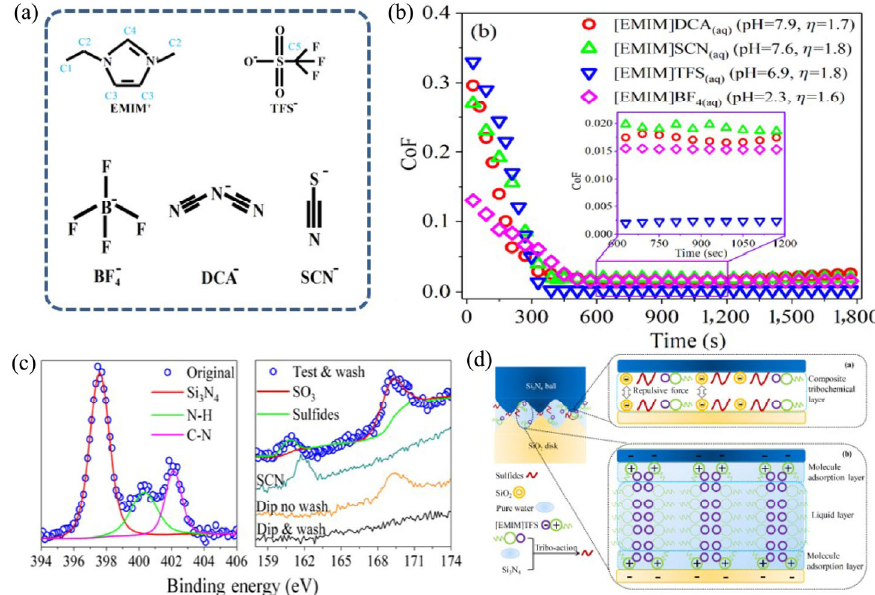
Fig. 7 (a) Molecular formulas of several ionic liquids and (b) corresponding friction coefficients with the ionic liquid content of 40 wt%, (c) XPS Spectra (N1s and S2p) of worn zone on silicon nitride ball lubricated by [EMIM]TFS aqueous solution, and (d) superlubricity model. Reproduced with permission from Ref. [74]. © American Chemical Soeity,